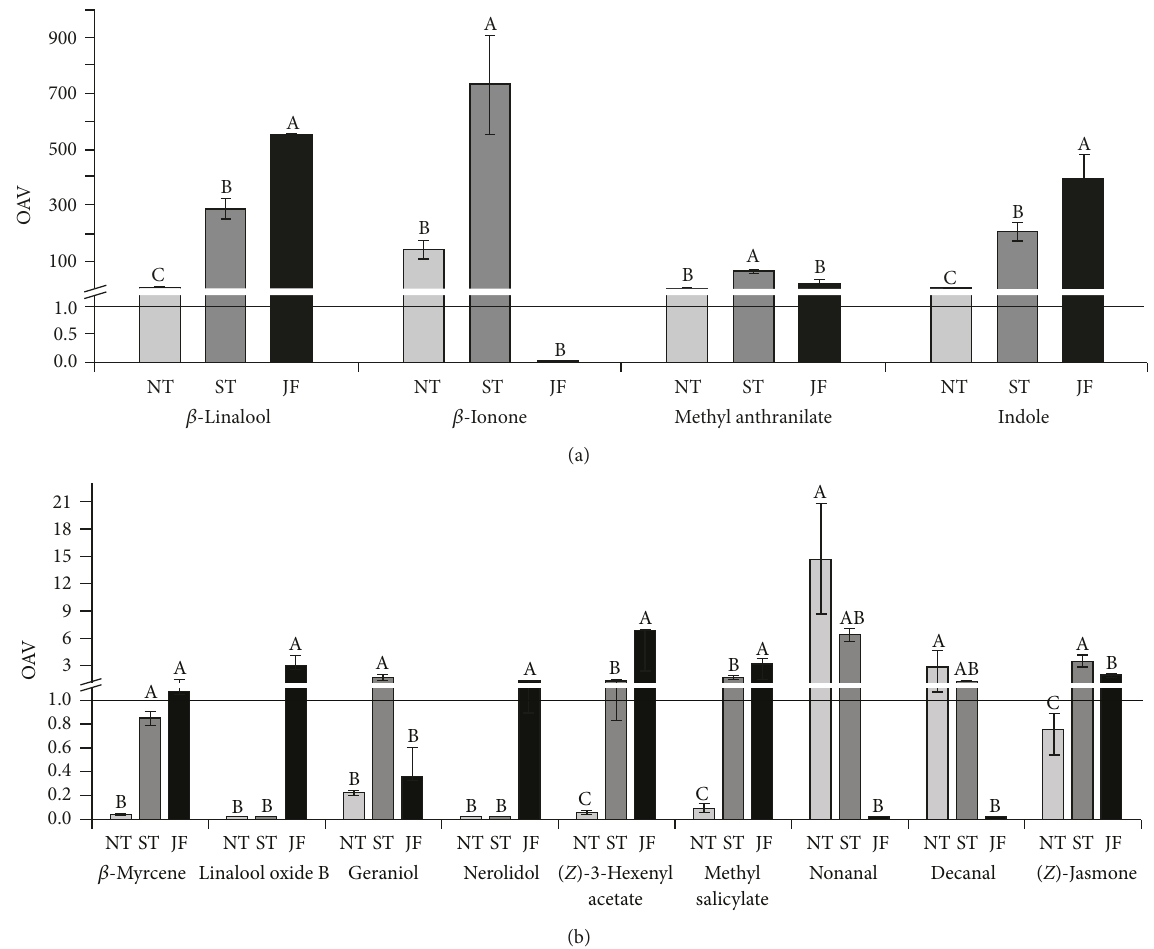
Figure 2: Odor activity values of volatiles ( > 1) found in the infusions of scented (ST) and nonscented (NT) green teas and jasmine flowers (JF) based on volatile abundances and their thresholds. Duncan’s new multiple range test was performed and the columns labeled with the same letter within the same compound had no significant difference among the three sample types, 𝑃 < 0.05 . (a) Volatiles with high OAVs. (b) Volatiles with low